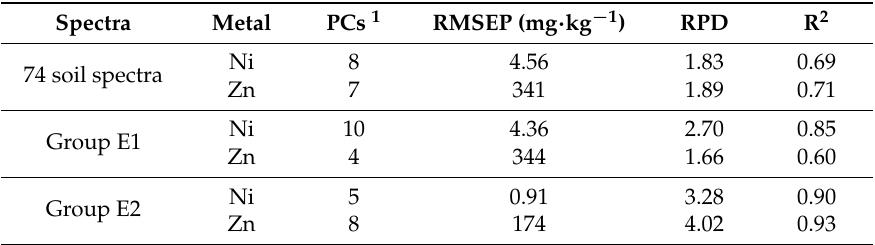
Table 2. Prediction accuracies based on squared Euclidean distance.